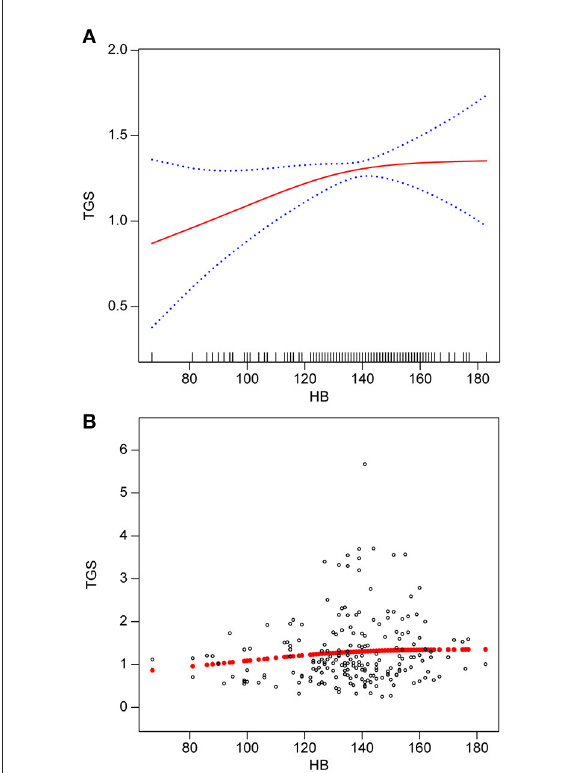
FIGURE2 Association between Hb (g/L) and TGs (mmol/L). (A) smooth fitted curve of Hb and TGs, (B) scatter plot for the distribution of Hb and TGs. The solid red line represents the smooth curve fit between the variables. The blue bands represent the 95% CI of the fit. The model is adjusted for sex; age; smoking status; alcohol consumption; BMI; disease type; TC; HDL-C; LDL-C; VLDL-C;